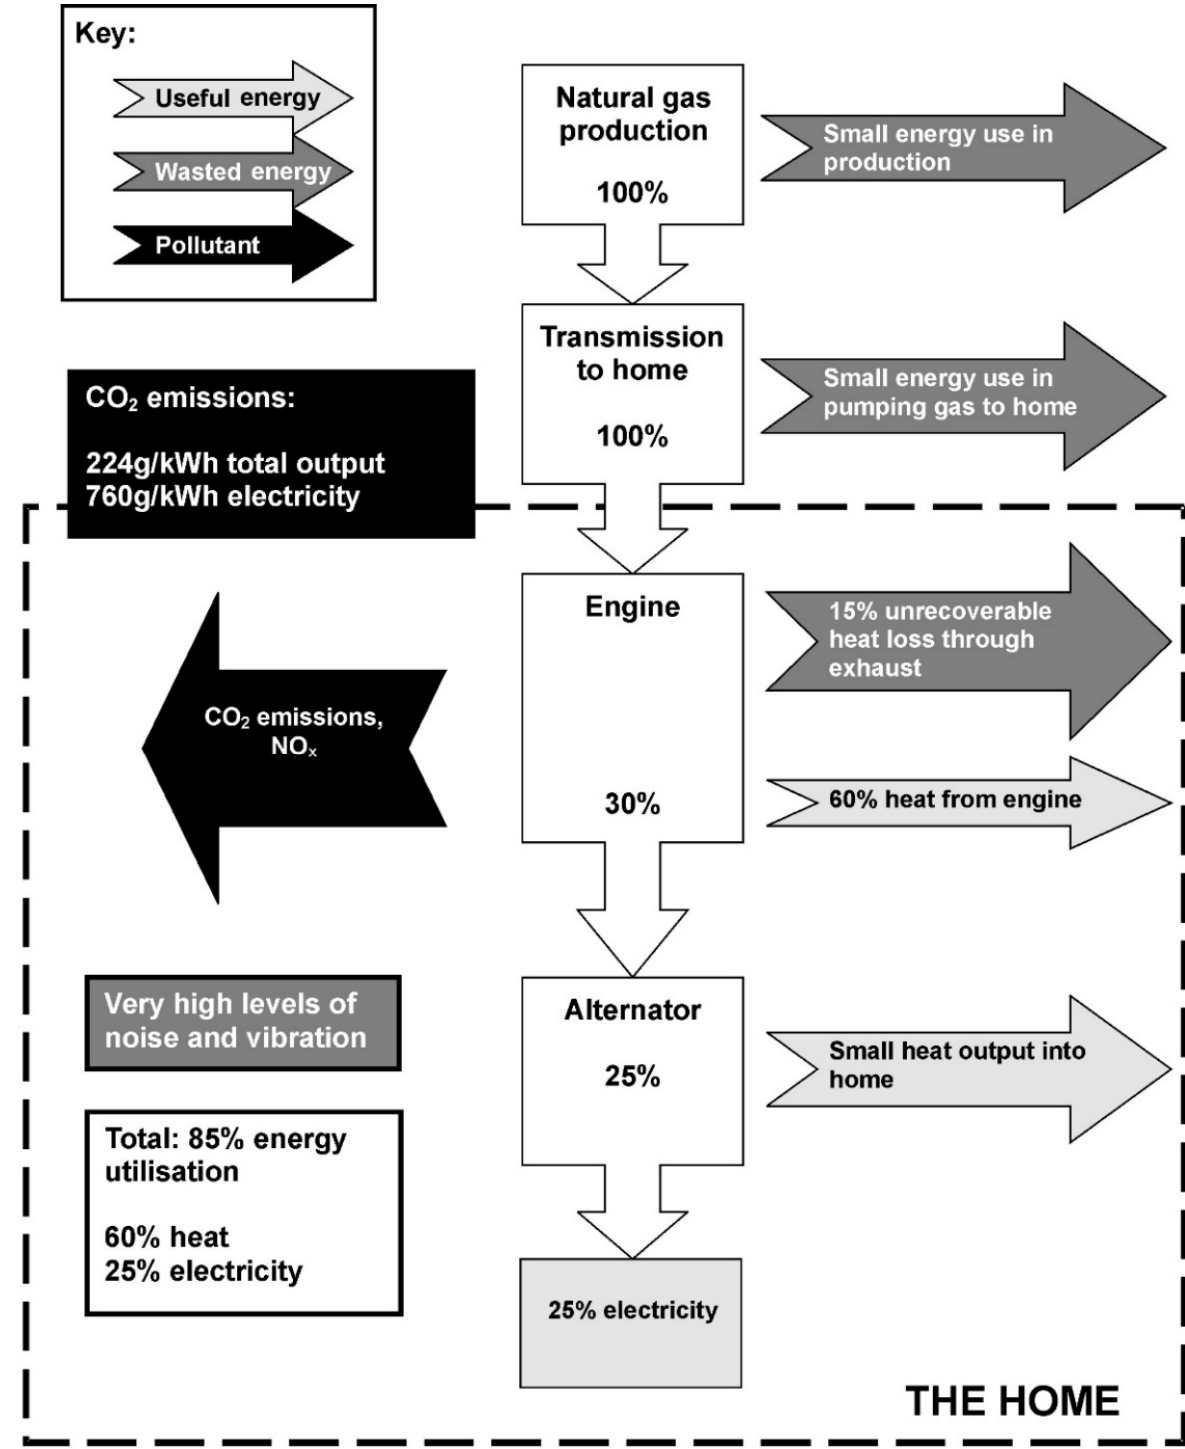
Figure 9. Indicative energy and emissions balances for a micro-CHP system based on a natural gas-fired internal combustion (IC) engine on a ‘full fuel cycle’ basis.